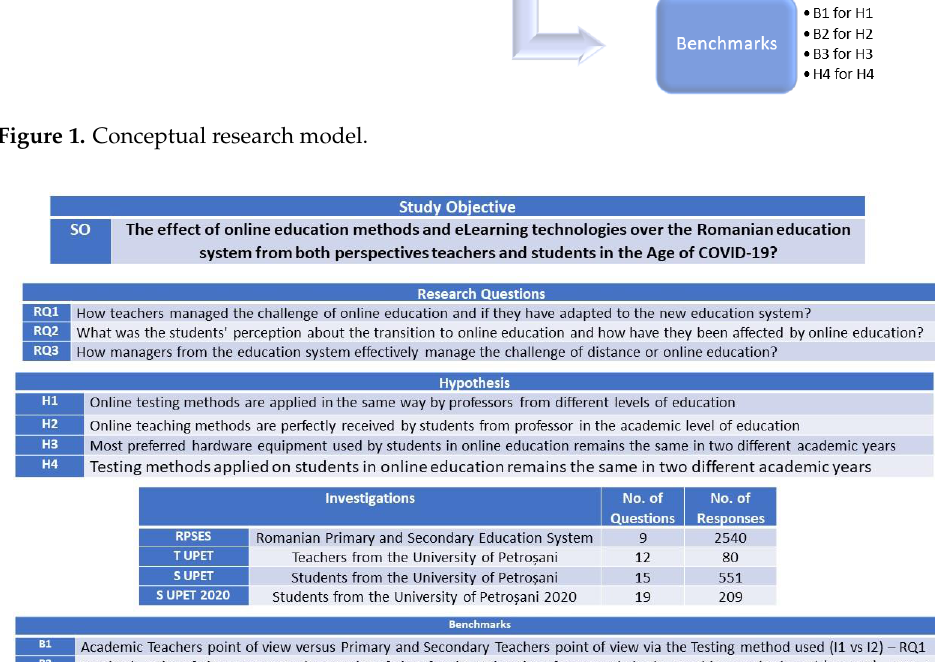
Figure 2. Detailed conceptual research